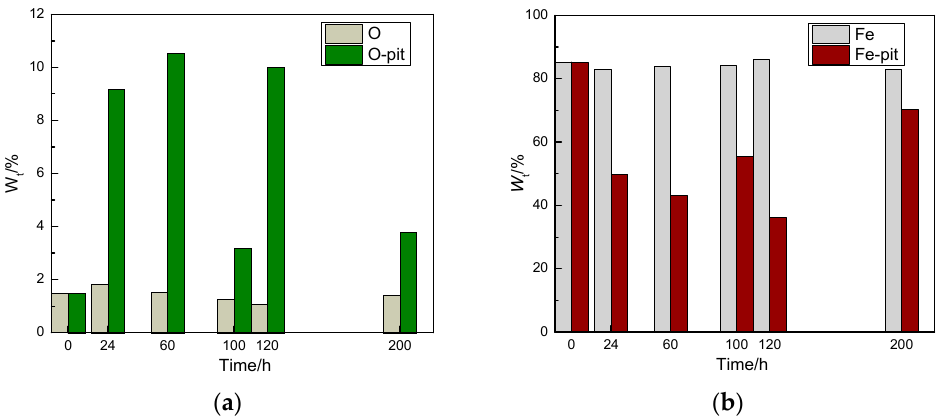
Figure 10. Analysis of the chemical elements inside and outside of the corrosion pits at different corrosion exposure times in corrosion-resistant alloy steel bars. (O-pit represents the O content inside the pits, Fe-pit represents the Fe content inside the pits). ( a ) O element contained in inside and outside of the corrosion pits; and ( b ) Fe element contained in inside and outside of the corrosion pits.